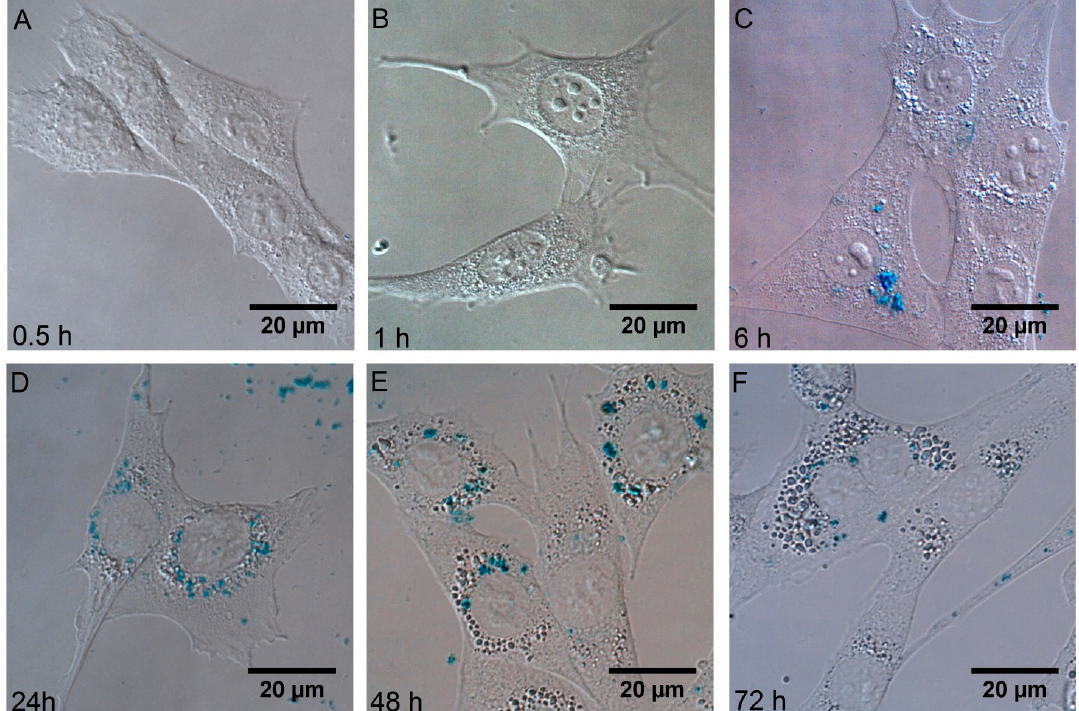
Figure 2. Fixed NIH3T3 cells after 0.5–72 h of incubation with 65 ng/mL of Fe 3 O 4 (stained with Prussian Blue) ( A – F ). The accumulation was observed using bright-field microscope equipped with digital color